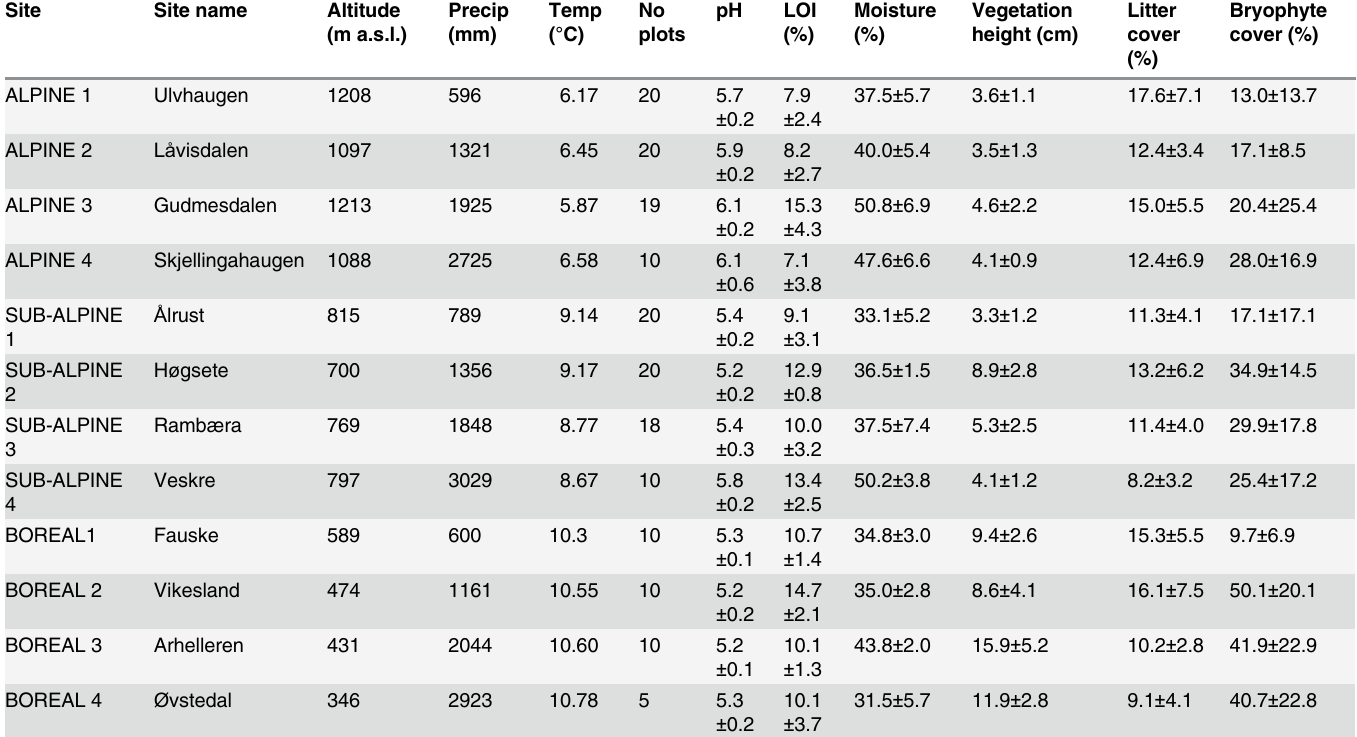
Table 1. Altitude, annual precipitation, summer temperature, number of plots sampled and mean ± standard deviations of predictor variables at al- pine, sub alpine, and boreal grassland sites along precipitation gradients (low [1] to high [4]) in southern Norway.